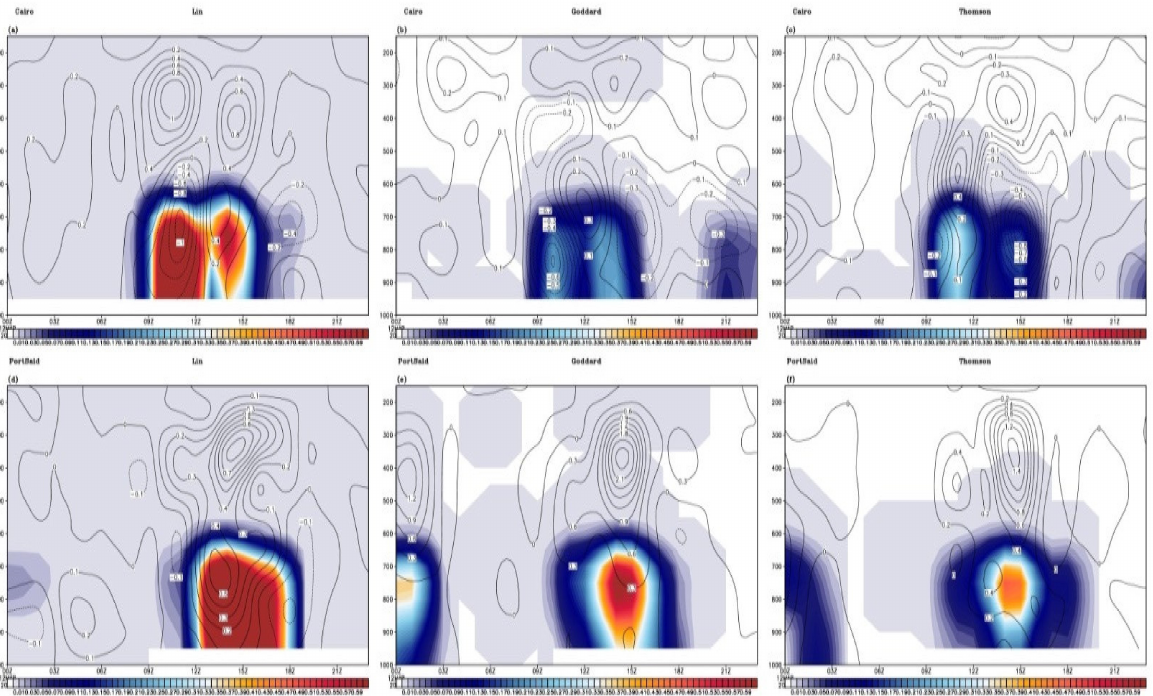
Figure 5. Vertical cross-section of water cloud mixing ratio (g/kg) is shown in the shaded color at 15 UTC on 12 March 2020. ( a ) Lin, ( b ) Goddard, and ( c ) Thompson for Cairo International Airport and ( d ) Lin, ( e ) Goddard, and ( f ) Thompson for Port Said International Airport. Vertical velocity (m/s) is shown in the solid black color line